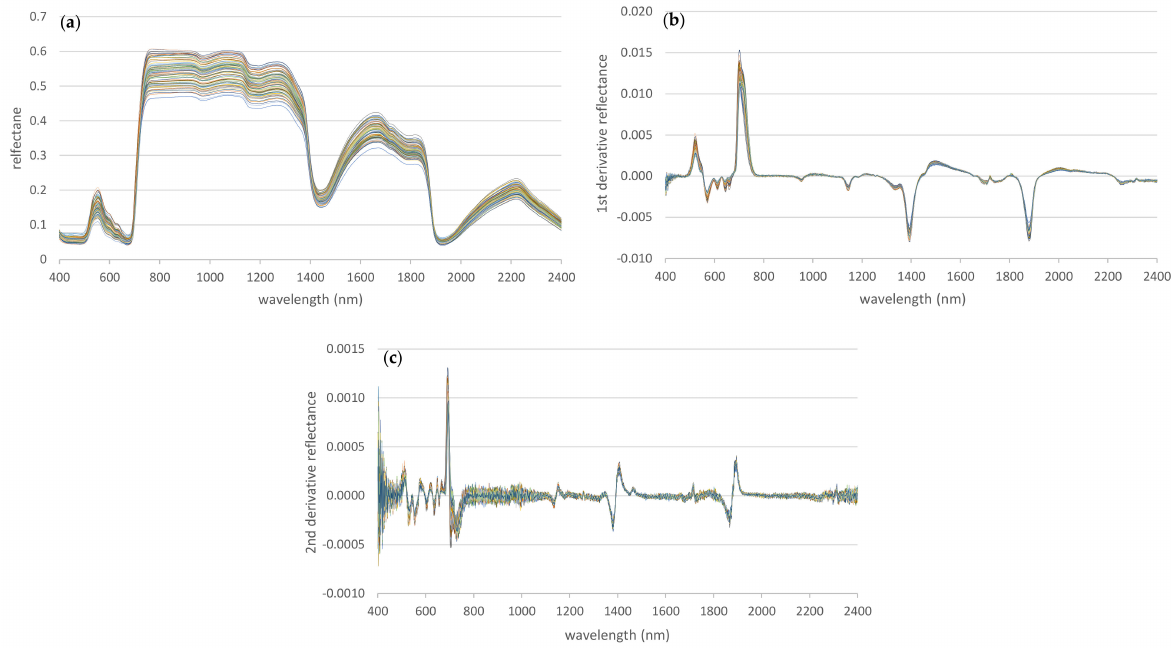
Figure 6. Raw hyperspectral signatures ( a ) and their first ( b ) and second ( c ) derivatives for all samples (n =